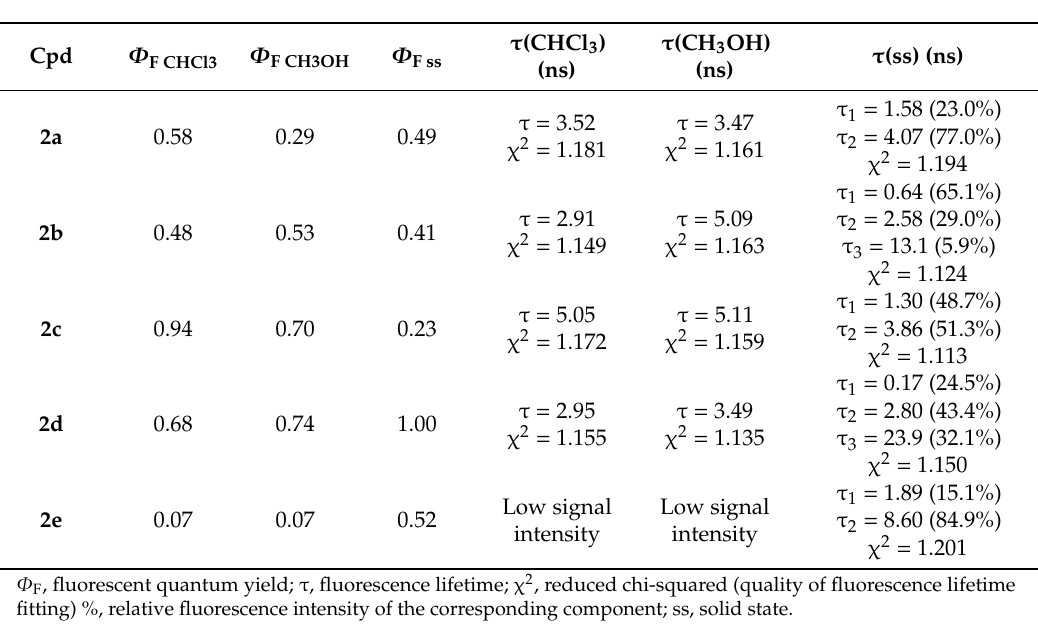
Table 3. Fluorescence characteristics of the studied carboline derivatives 2a – 2e .